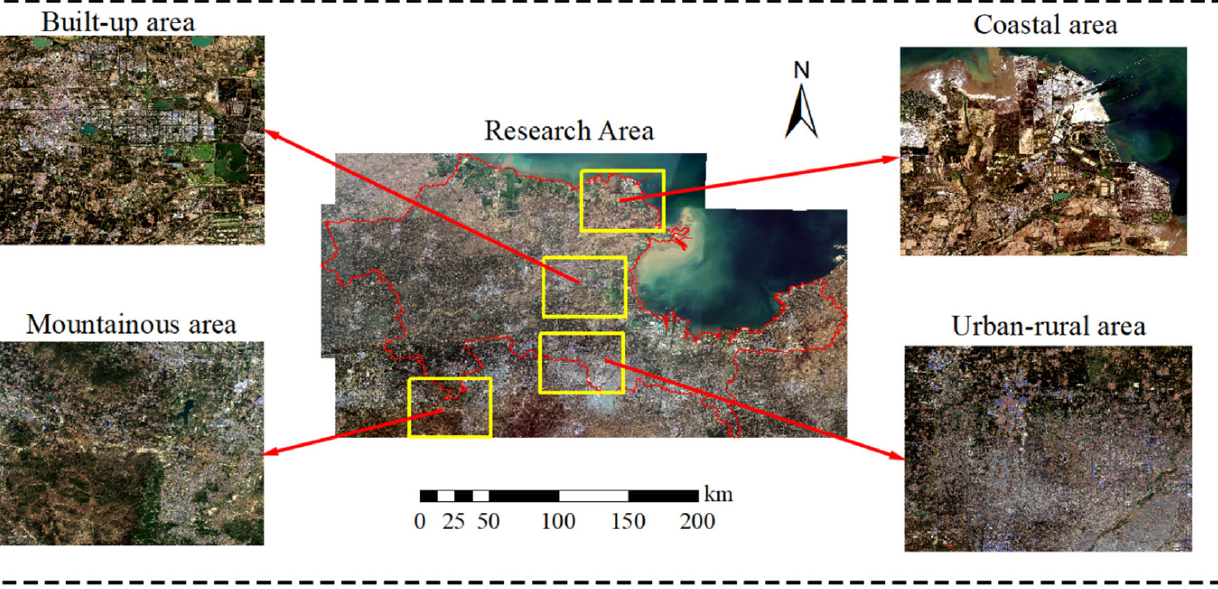
Figure 5. Schematic diagram of Random Forest for classification.